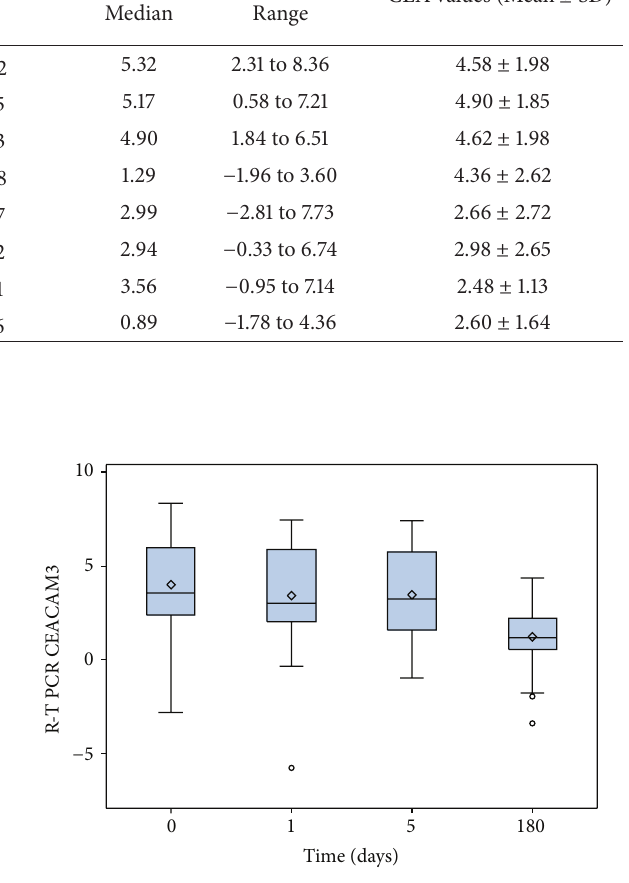
Figure 1: Decreasing trend of overall CEACAM3 values from pre- operative through early and later postoperative to 6th-month blood samples.